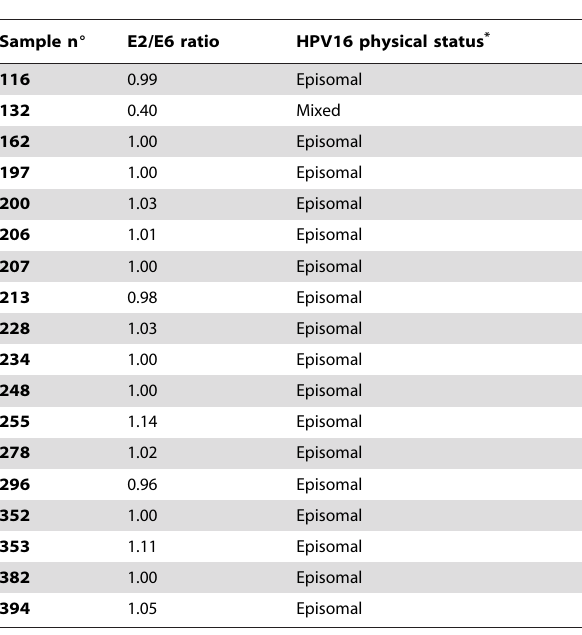
*inferred from the cut-off value for mixed versus episomal forms (0.60).